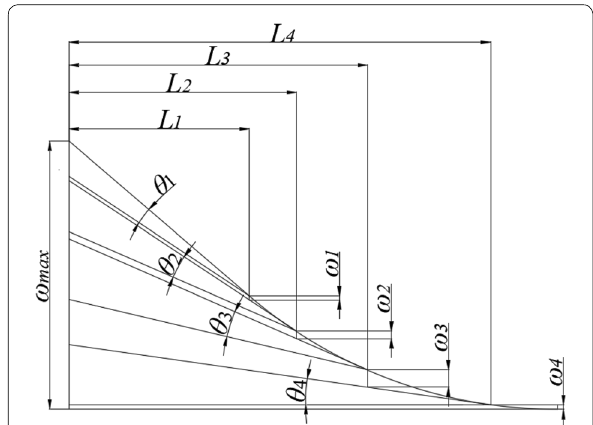
Figure 11 Schematic diagram of the total deflection of the long stringer